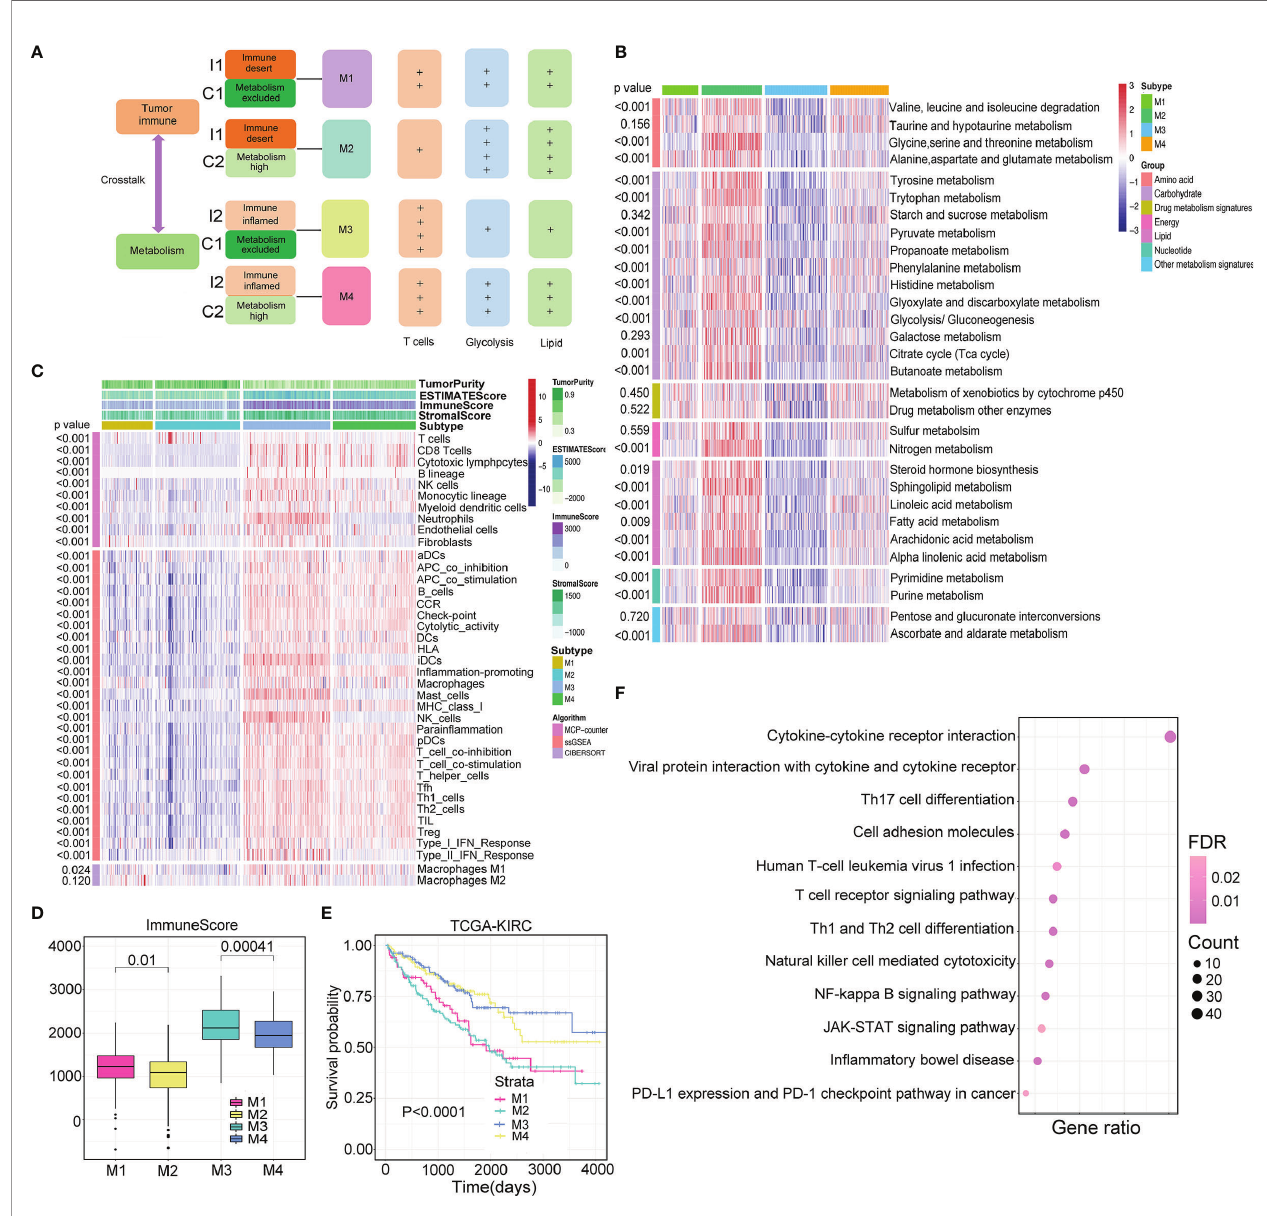
FIGURE 4 | Identi fi cation of four immunometabolism subtypes. (A) The diagram of immunometabolism classi fi cation strategy. (B , C) Heatmaps of metabolism- and immune-related signatures in four immunometabolism subtypes (M1, M2, M3, and M4). p -value is calculated by ANOVA test. (D) Comparison of immune score and stromal score in four subtypes. p -value is calculated by ANOVA test. (E) Comparison of survival outcomes among four subtypes. p -value is given by log rank test. (F) Speci fi c differentially expressed genes in M2 subtype compared with other subtypes involve in multiple immune relevant